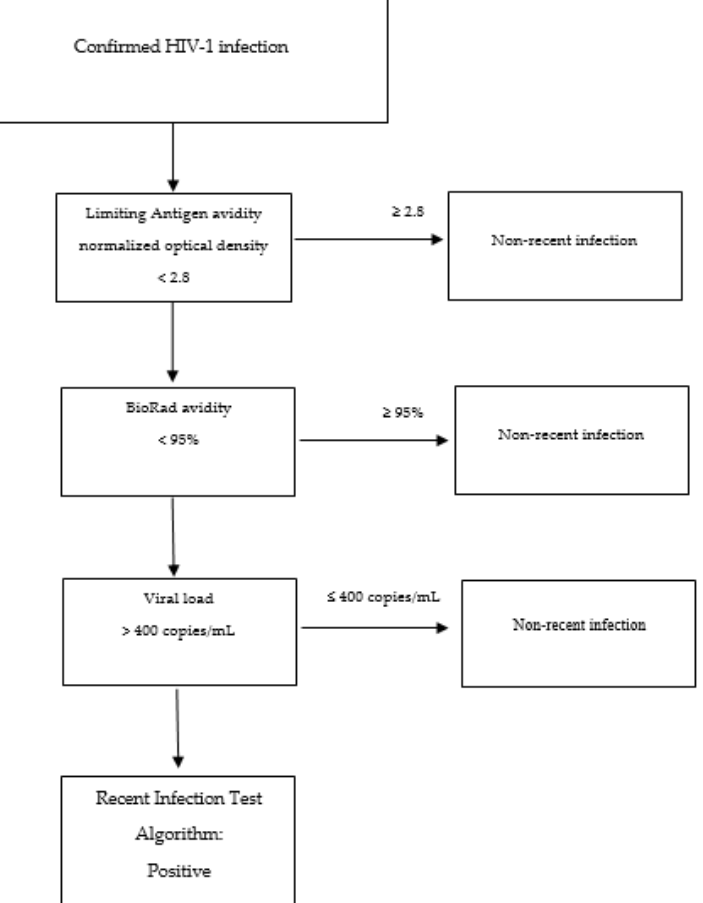
Figure 2. Example of the flow of a recent infection test